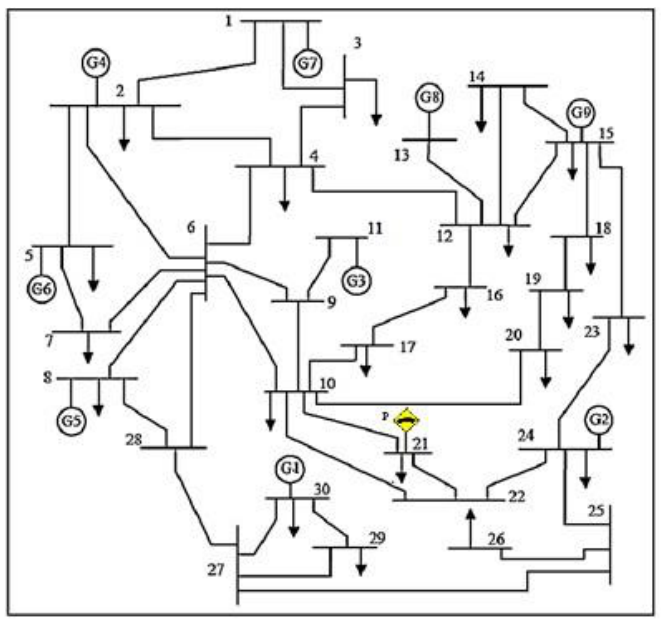
Figure 11. The 30-bus system.